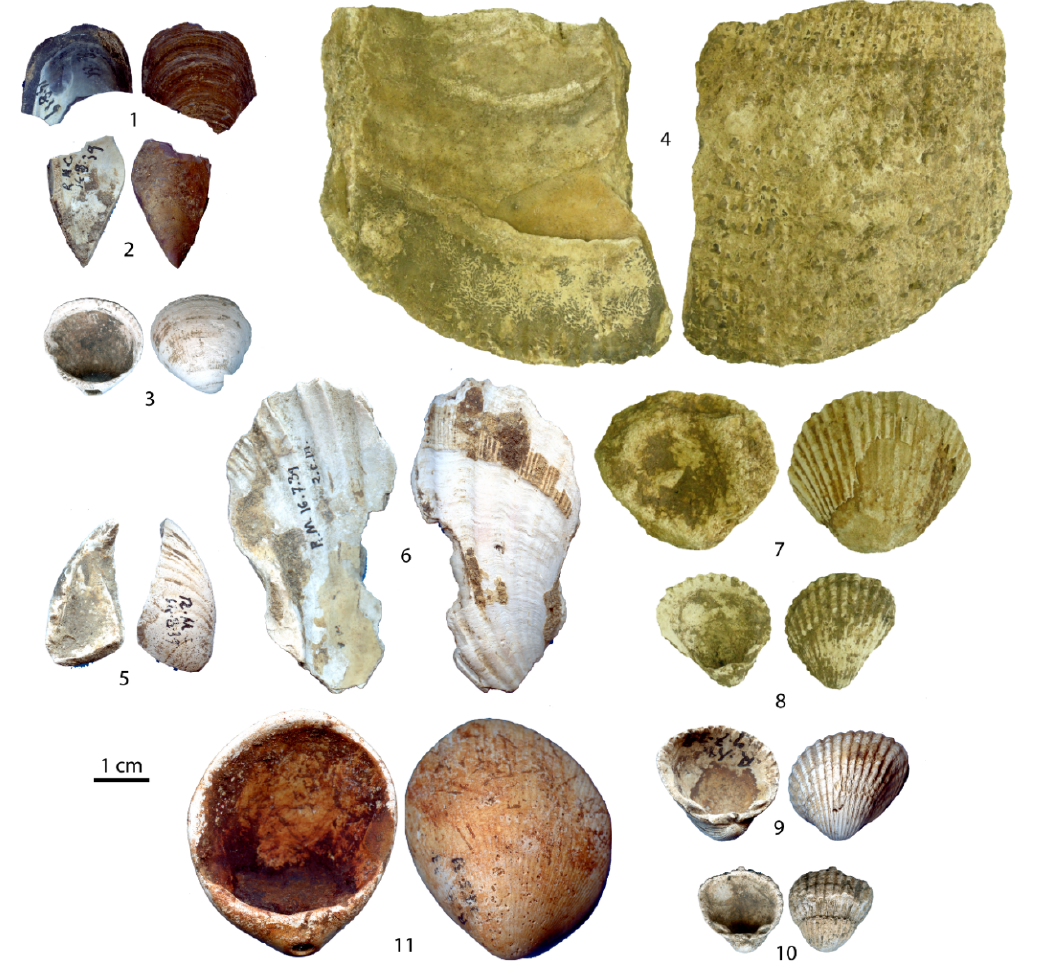
Figure 3: Bivalves recovered in the Upper Magdalenian from Rochereil. 1, 2) Mytilus sp., 3, 11) Glycymeris sp., 4) Spondylus sp., 5) indet., 6) Pecten maximus , 7-8) Cardiidae indet ., 9-10) Cerastoderma